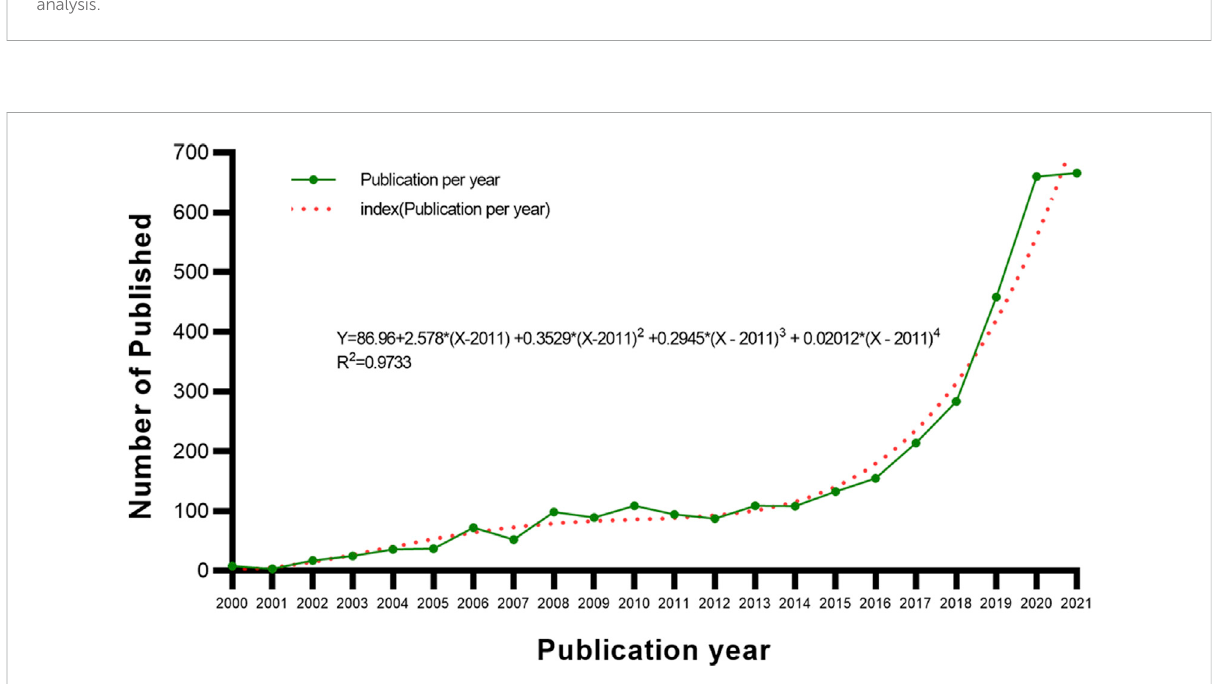
FIGURE 2 Trends in the number of publications on ABAM from 2000 to